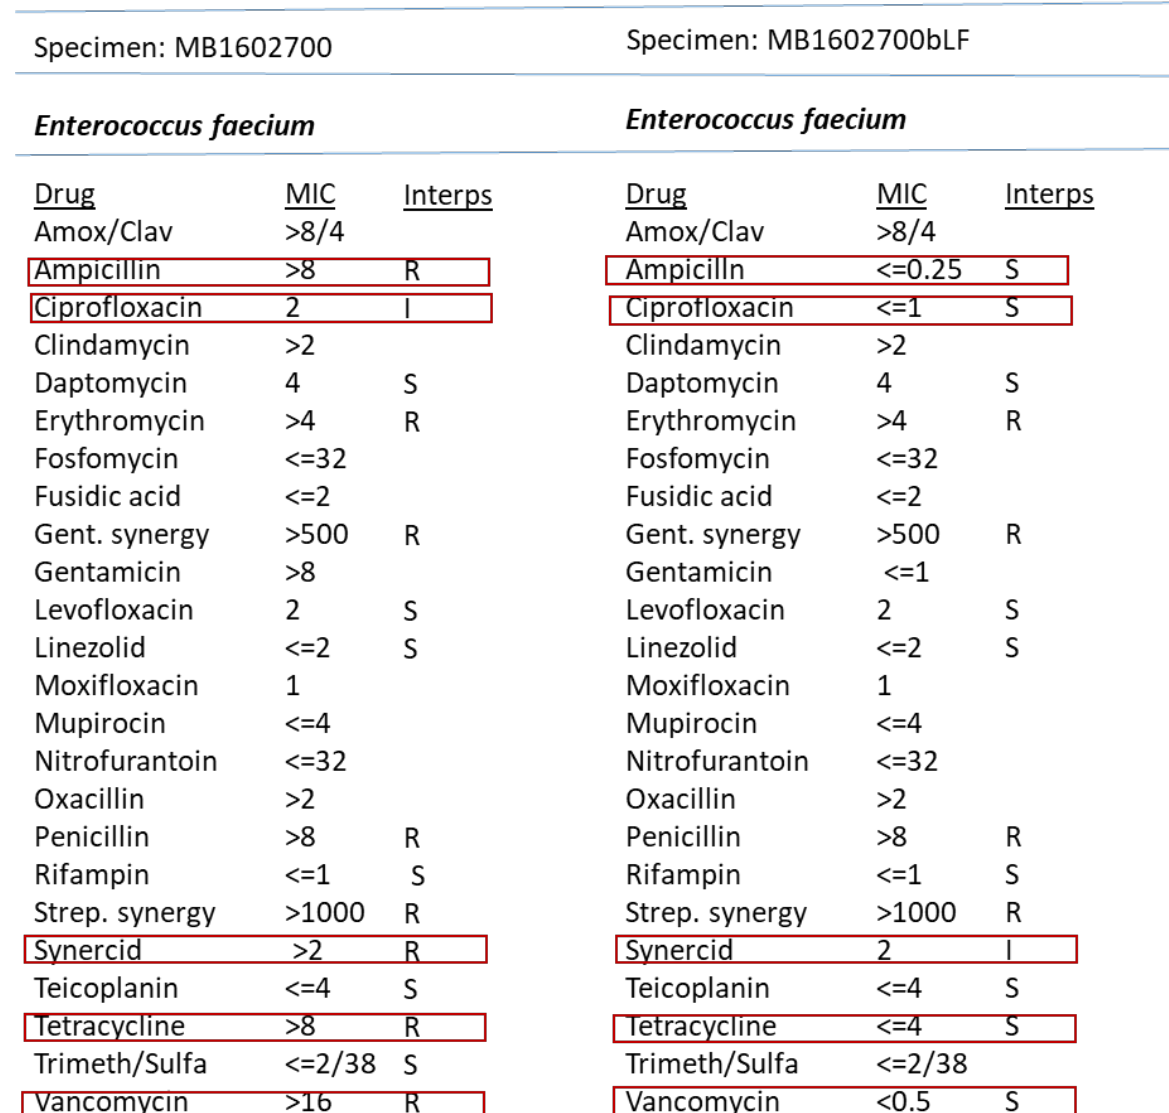
Figure 9. Demonstration of effect of bovine lactoferrin (bLF) on Vancomycin resistant Enterococcus faecium (VRE)